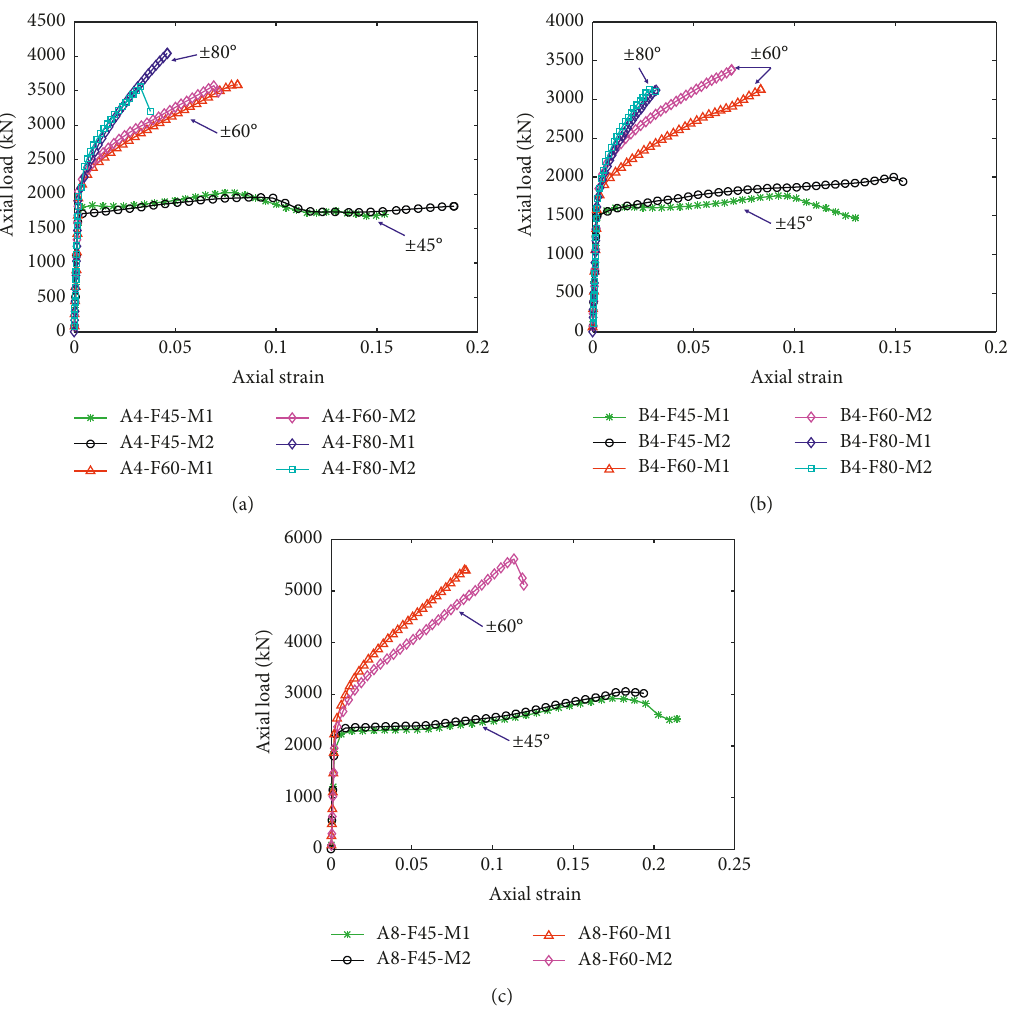
� 4mm; Type A steel tube. (b) t frp